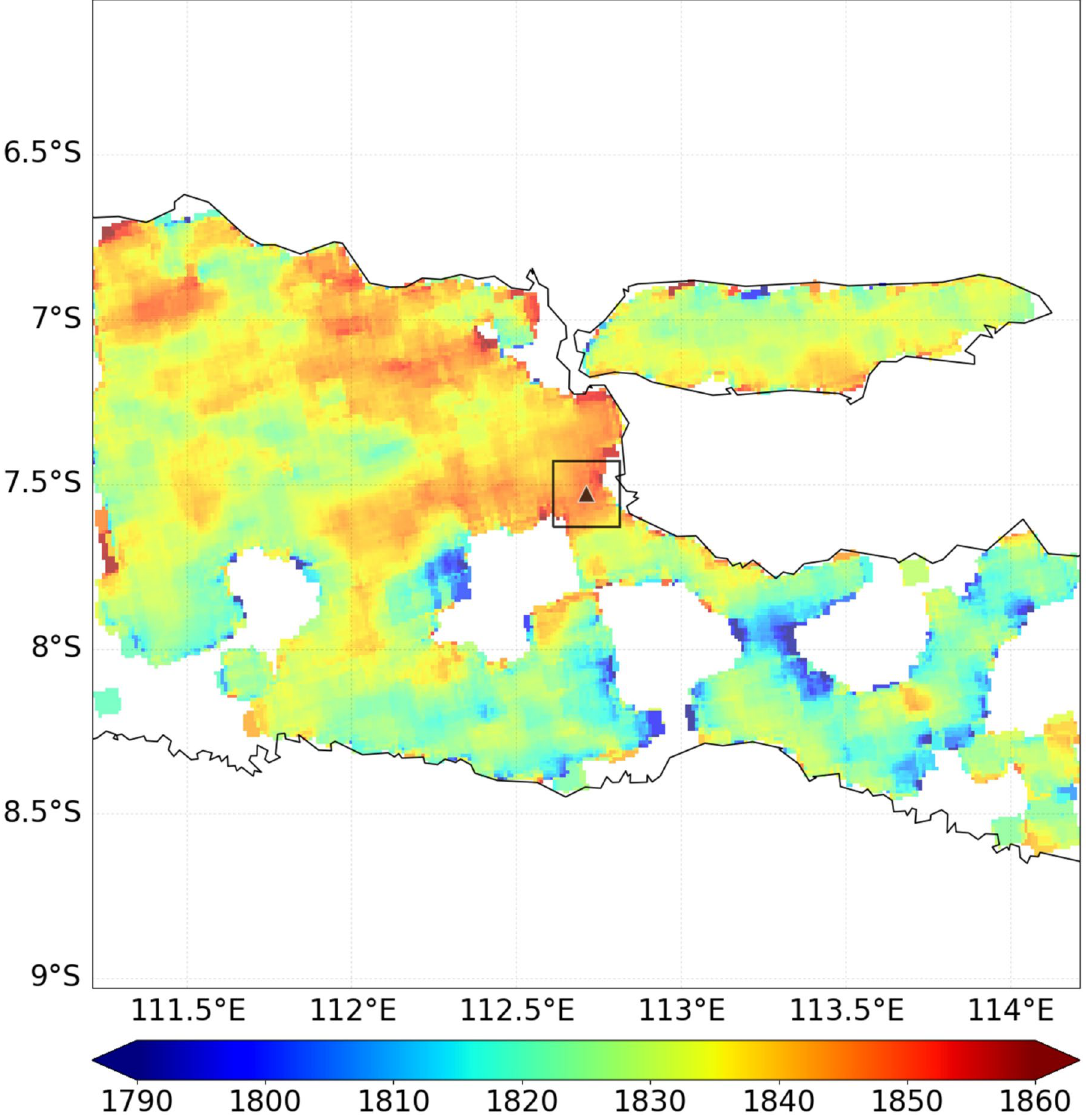
Figure 3. An oversampled (0.01° × 0.01°) map of TROPOMI data averaged over the study domain from May 2018 till July 2019. The location of Lusi is indicated by a triangle and the square denotes the source box. Units in ppb. Map generated using Python 2.7.13